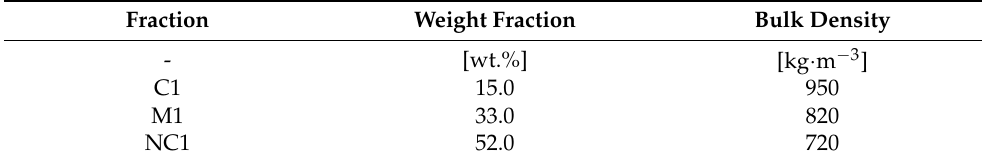
Table 2. Weight fraction and bulk density in ESS fractions.